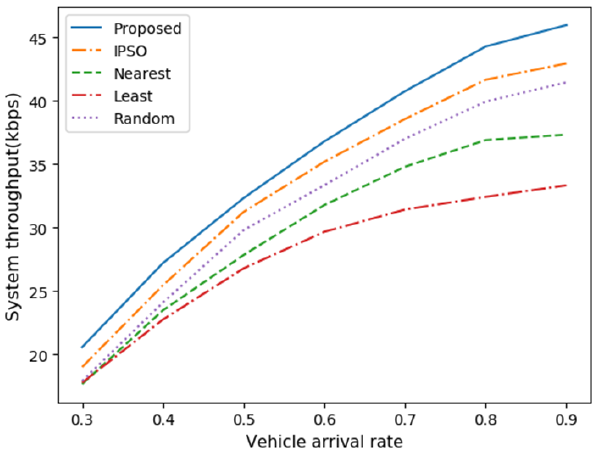
Figure 10. Blocking rates for vehicle arrival rate.